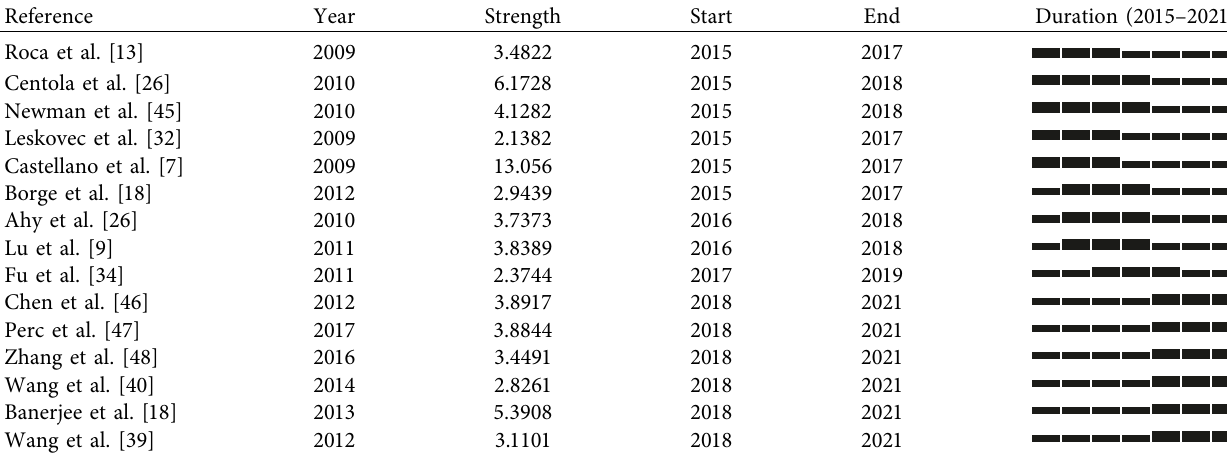
Figure 5: Time axis diagram of dynamic complex network research keywords. Table 5: Top 15 references with strongest citation bursts.